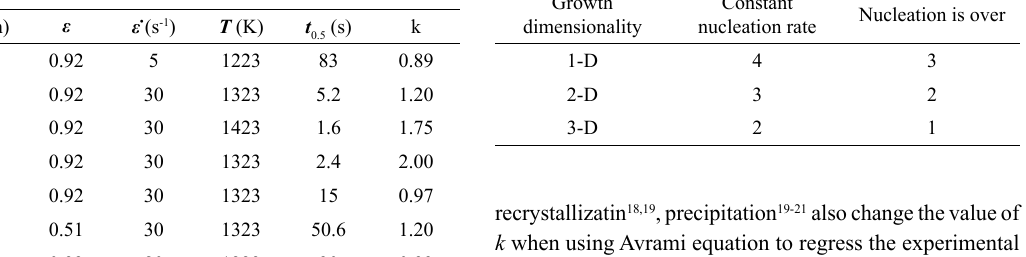
Figure 2. Effect of initial grain size (a), strain rate (b), strain (c) and temperature (d) on the kinetics of recrystallization. (a) d ε=0.92, T =1223K; (b) d =520um, ε̇ =30s -1 , T =1323K; (c) ε=0.92, ε̇ =30s -1 , T =1323K; (d) d =520um, ε=0.92. rex 0 rex rex 0 Table 2. Ideal exponents in Avrami Table 1. Regression results for time to 50% recrystallization and k in Avrami equation.